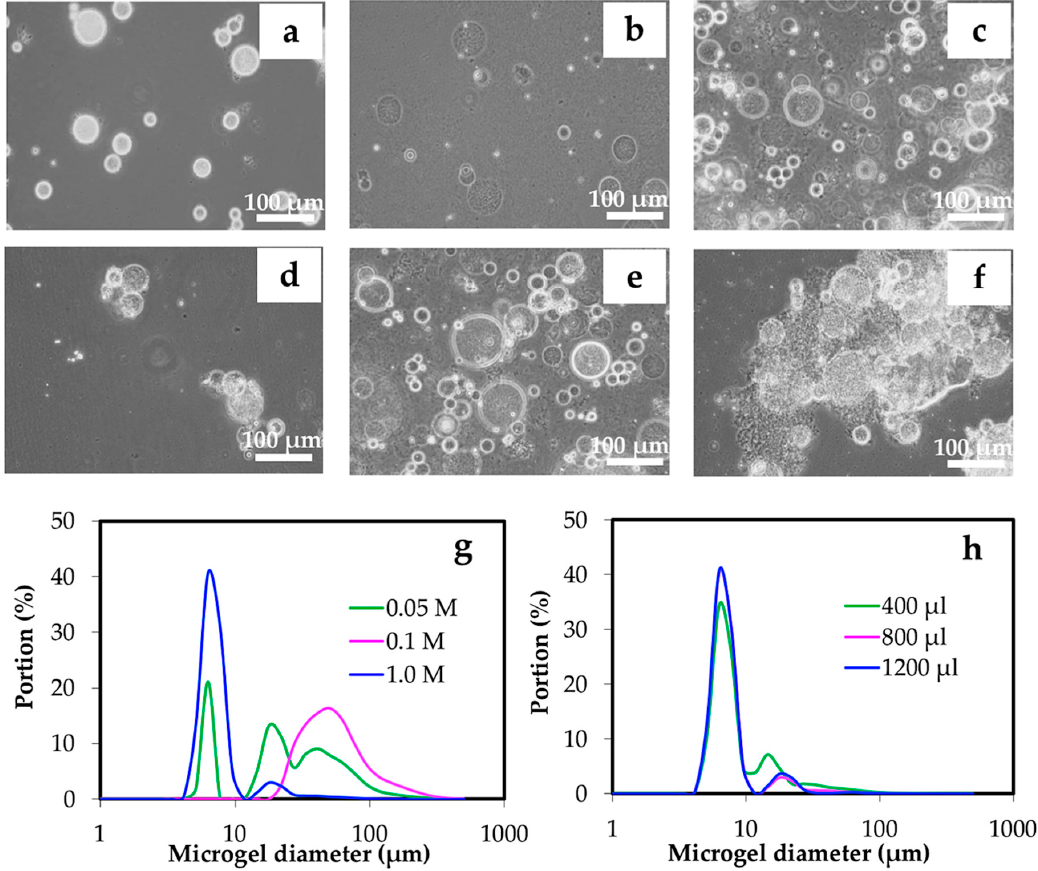
Figure 7. Optical microscopic images of microgels prepared from gelation using HCl at the concentrations of 0.05 M ( a ), 0.1 M ( b ), and 1.0 M ( c ), and 400 µ L ( d ), 800 µ L ( e ), and 1200 µ L ( f ) of 1.0 M HCl by controlling the concentration of chitin solution of 3% w / w at an O:W ratio of 15:1, and concentration of Span 80 (HLB 4.3) at 5% w / w in the oil phase. The representative size distributions of microgels prepared by different concentrations and volume of HCl are shown in ( g ) and ( h ), respectively.